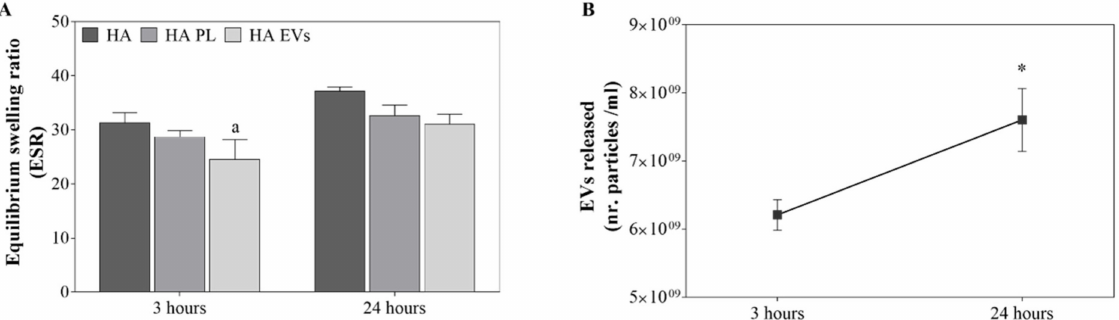
Figure 4. HA gel characterization. ( A ) Equilibrium swelling ratio (ESR) at 3 h and 24 h for each gel formulation. ( B ) EVs released per mL of HA-EVs gel at 3 h and 24 h. Values represent the mean ± SEM. Three independent samples ( n = 3) were evaluated. ESR results were statistically compared by ANOVA using DMS as a post hoc, while EVs released were compared by independent samples t-test. Statistically significant differences were considered for p < 0.05 and represented with “a” compared to HA and * compared to 3